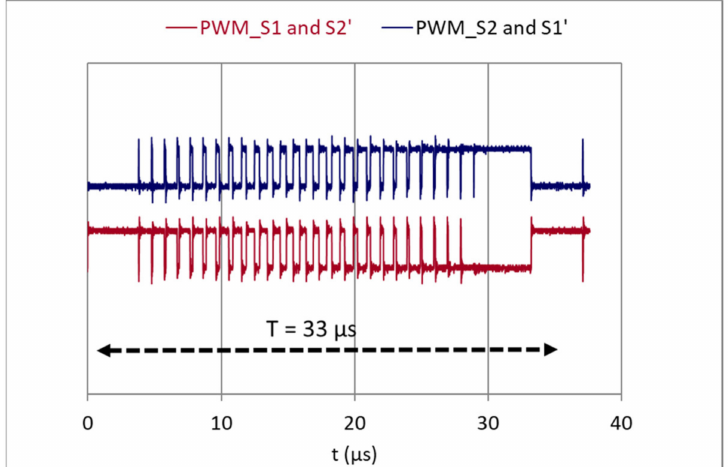
Figure 6. One period (33 µ s) of the complementary PWM signals. Frequency of the PWM is 1 MHz. Magnitudes of both PWM signals are changing from 0 to 5 V.